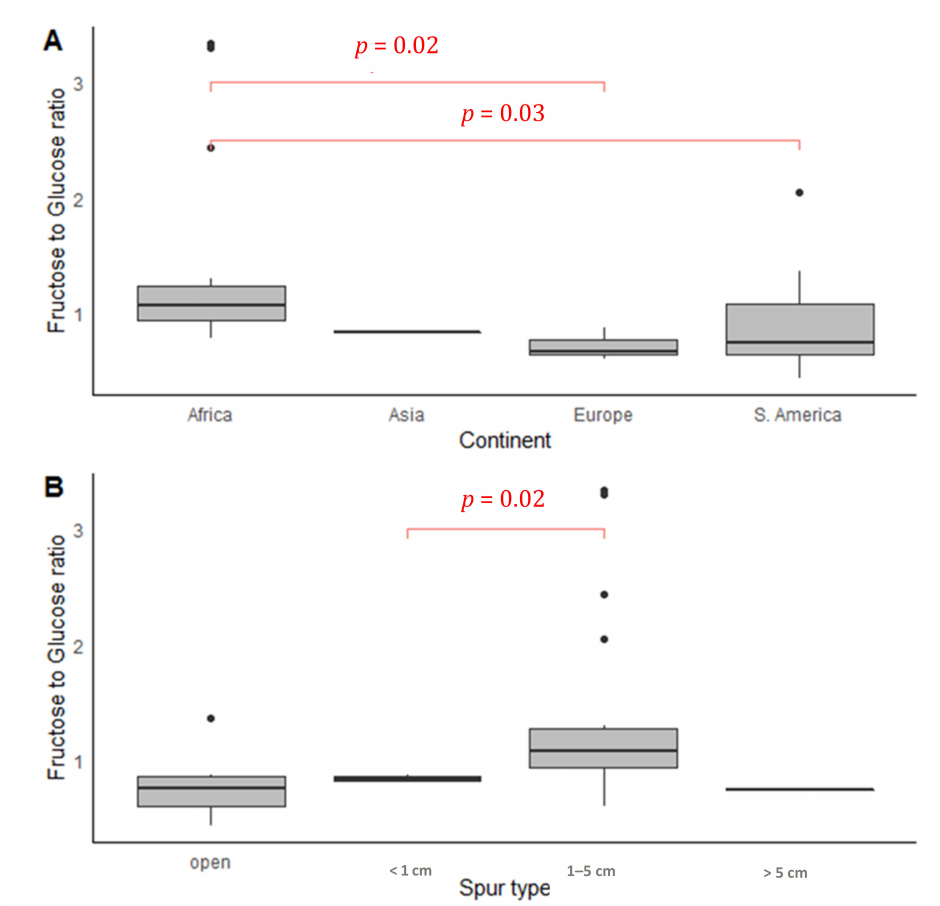
Figure 3. Fructose-to-glucose ratio in the nectar of 30 orchid species compared between continents ( A ) and spur type ( B ). Significant differences in Dunn’s multiple comparison test are indicated using red lines and red